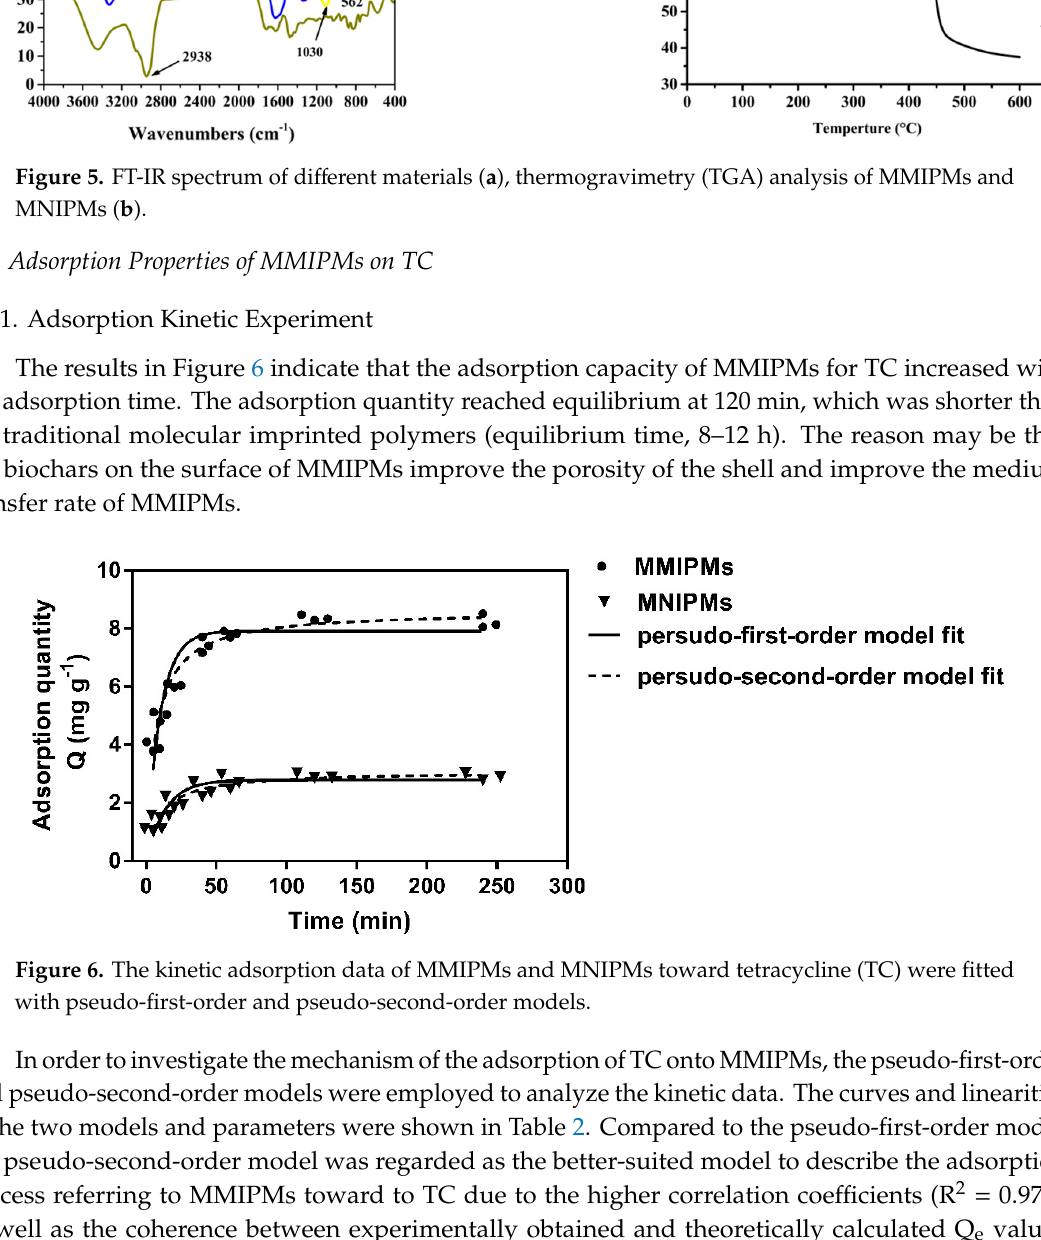
Table 2. The fitting parameters of the pseudo-first-order and pseudo-second-order kinetic adsorption models for TC.